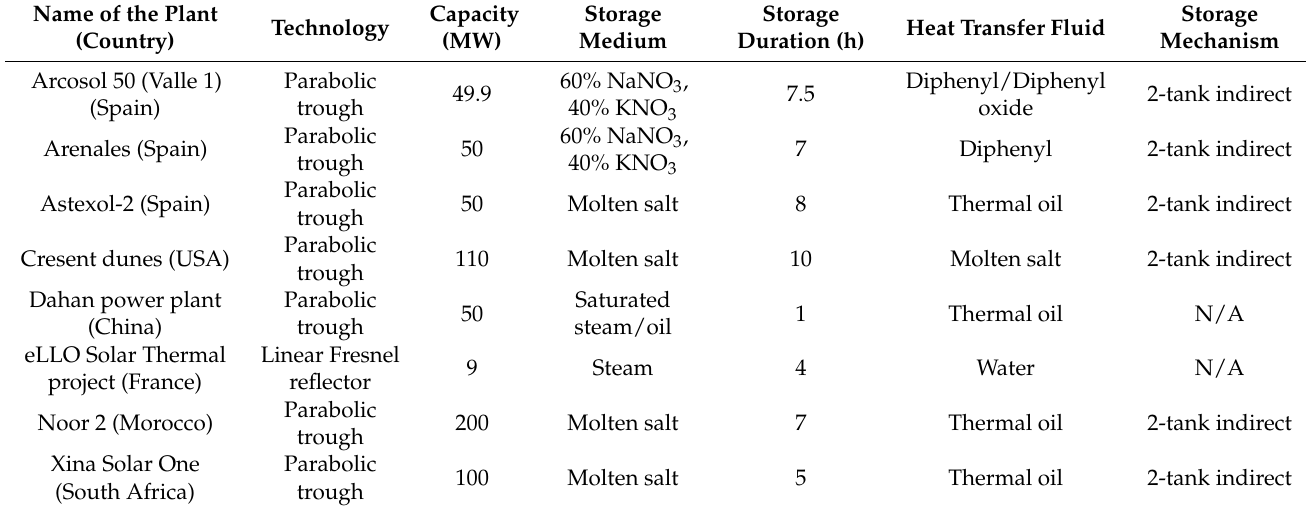
Table 1. Globally operational concentrated solar plants with energy storage systems